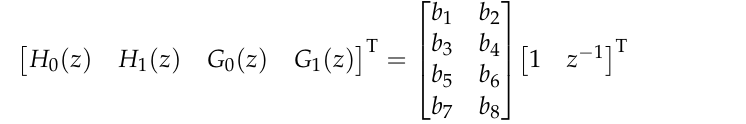
Table 1. State parameters of the two ‐ channel quadrature filter bank. Filters